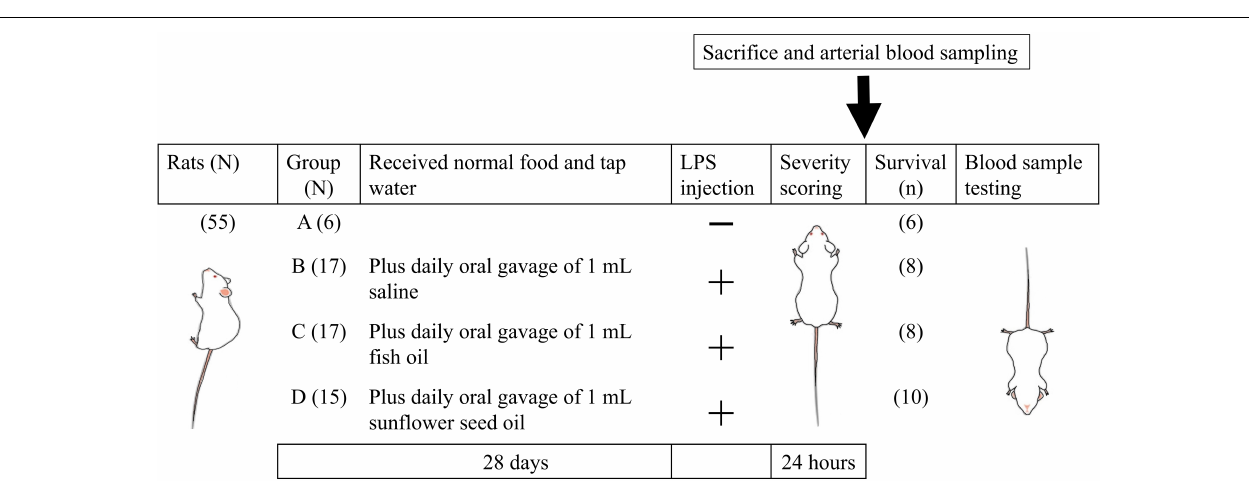
protocol. The anti-CD40L-FITC (BD) monoclonal antibody